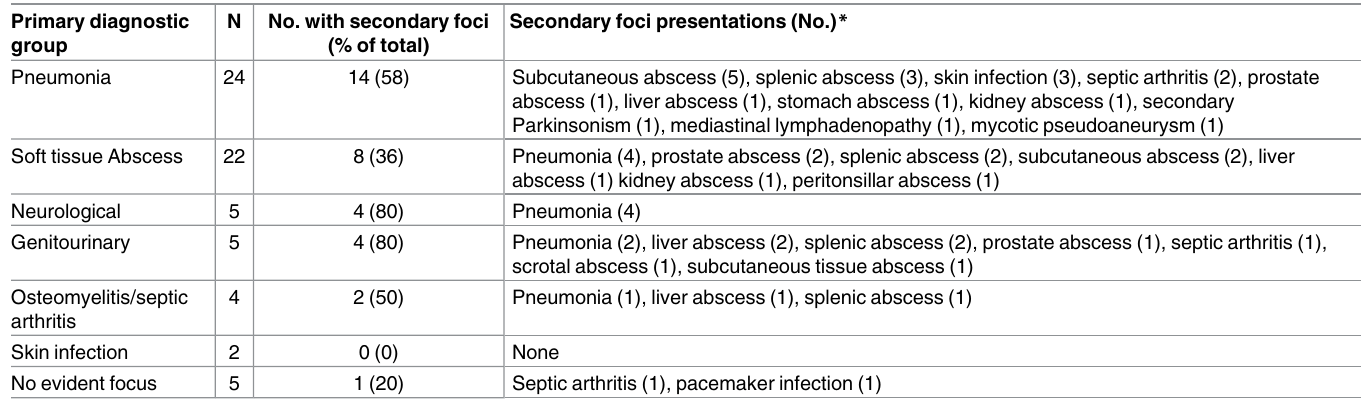
Four cases of brain or spinal cord abscesses were noted. Pericardial effusion occurred in one case and another had infection of the pacemaker device. One case of parotid abscess was noted. Next, details of selected clinical presentations that are known to vary by geographic area are discussed. There were seven cases (13%) with prostatic abscesses with ages ranging from 41 to 63 years of age. All of the seven cases had one or more predisposing risk factors: diabetes (n = 6); hyper- tension (n = 4); tuberculosis (n = 2); or smoking and excessive alcohol use (n = 1). Six of the seven were bacteremic. Presenting symptoms of dysuria, increased frequency of urination or retention of urine were noted only in two cases both of whom were bacteremic and had a fatal